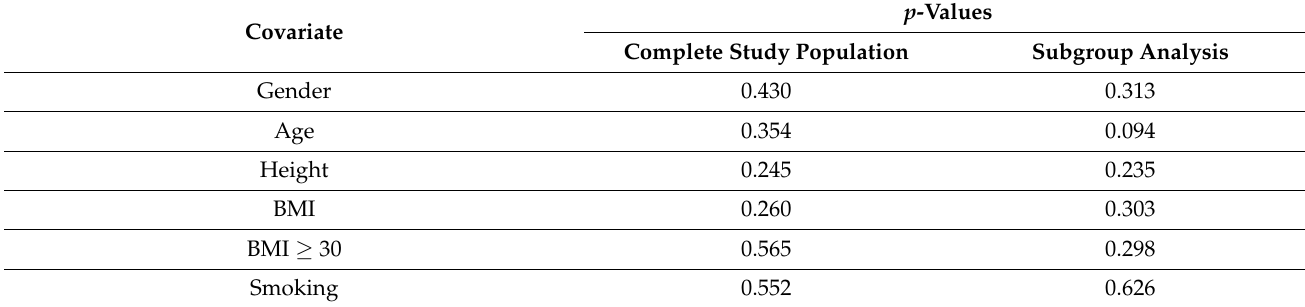
Table 3. Covariate effects on the algorithm’s performance.